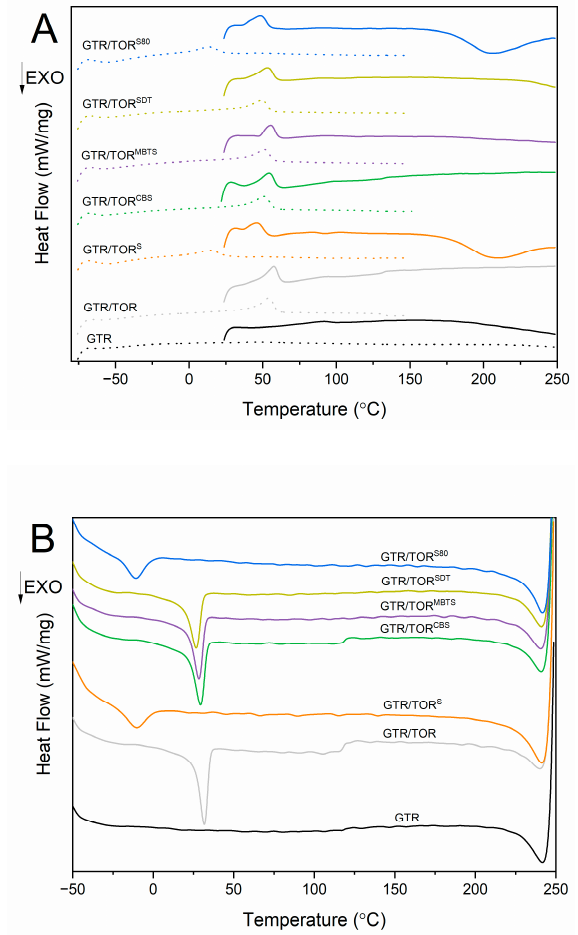
Figure 8. Differential scanning calorimetry (DSC) thermogram evaluating the melting ( A ) and crystallization ( B ) of the studied samples (straight line—1st run; dot line—2nd run).